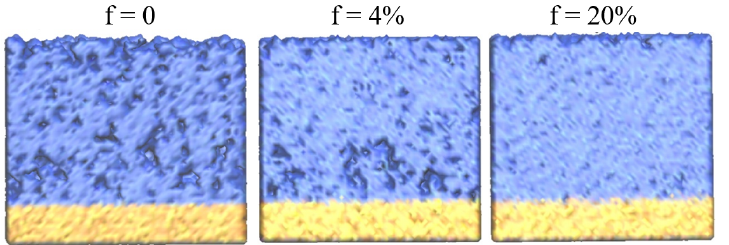
Figure 3. Atomistic structure of deposited films for various fractions of assisting oxygen atoms, f; energy of assisting ions E = 100 eV.